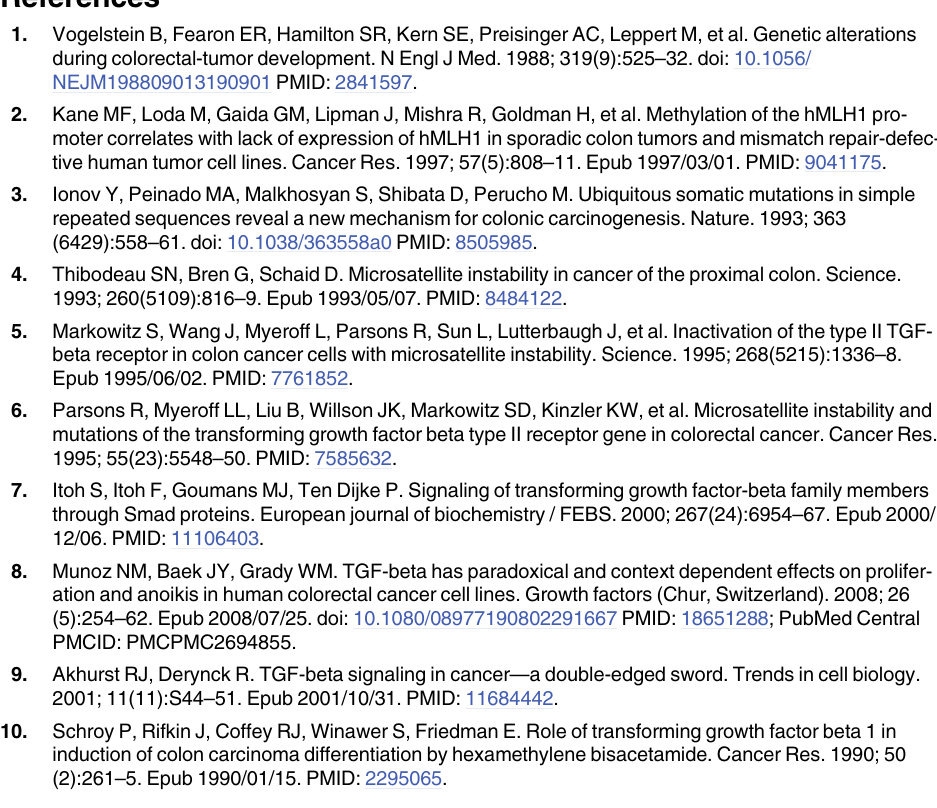
S1 Table. List of proteins identified by mass spectrometry analysis in presence of the label- ing reagent L-Azidohomoalanine (AHA). The click-it approach was applied prior to mass spectrometry to allow the identification of newly synthesized proteins. The data were obtained for both cell clones, HCT116-TGFBR2 #5 and #22, in triplicate in presence and absence of TGFBR2 expression. Asterisks indicate proteins that were identified in presence of cyclohexi- mide (CHX), an inhibitor of protein biosynthesis and hence are not newly